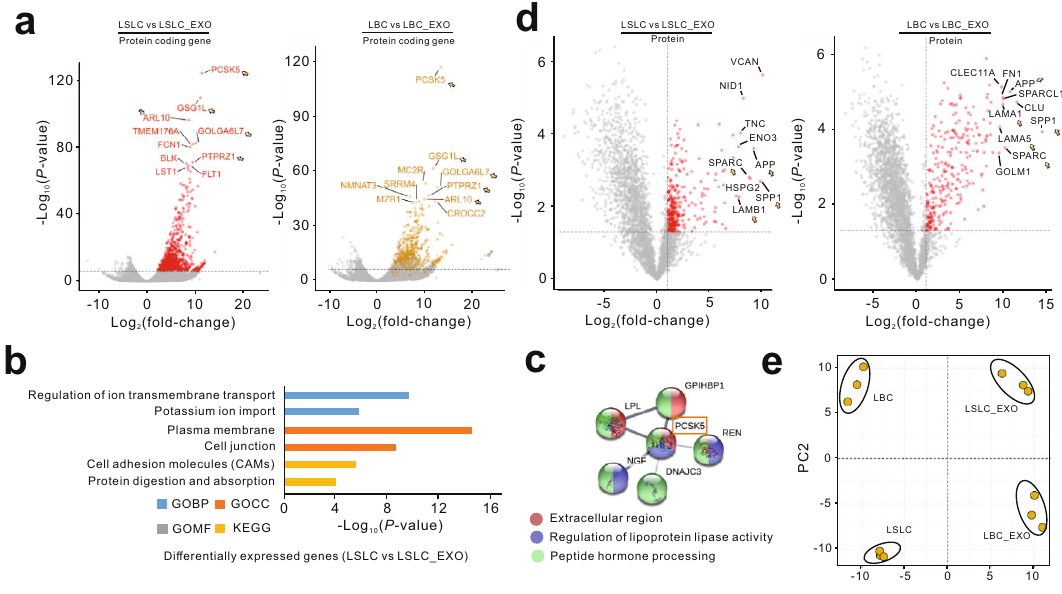
Fig. 6 Identi fi cation and functional characterization of exosomal-enriched RNAs and proteins. a Volcano plots showing exosomal-enriched protein-coding genes identi fi ed using transcriptomic data. Red dots denote the genes passing our P value and fold difference thresholds. Yellow dots in the right panel denote the LSLC-EXO-enriched genes (the red dots in the left panel). The genes listed in the top 10 signi fi cance are marked with gene names. Arrows denote the common genes between cells and exosomes. b Functional annotation of differentially expressed genes between LSLC and LSLC-EXO. c The PPI subnetwork of PCSK5 obtained from the STRING database. The signi fi cantly enriched gene annotations are listed in the bottom and colored. d Volcano plots showing exosomal-enriched proteins identi fi ed using proteomic data. e Principal component analysis based on LSLC-EXO-enriched (Fig. 6b, Supplementary Fig. 9a, and Supplementary Data 6). When